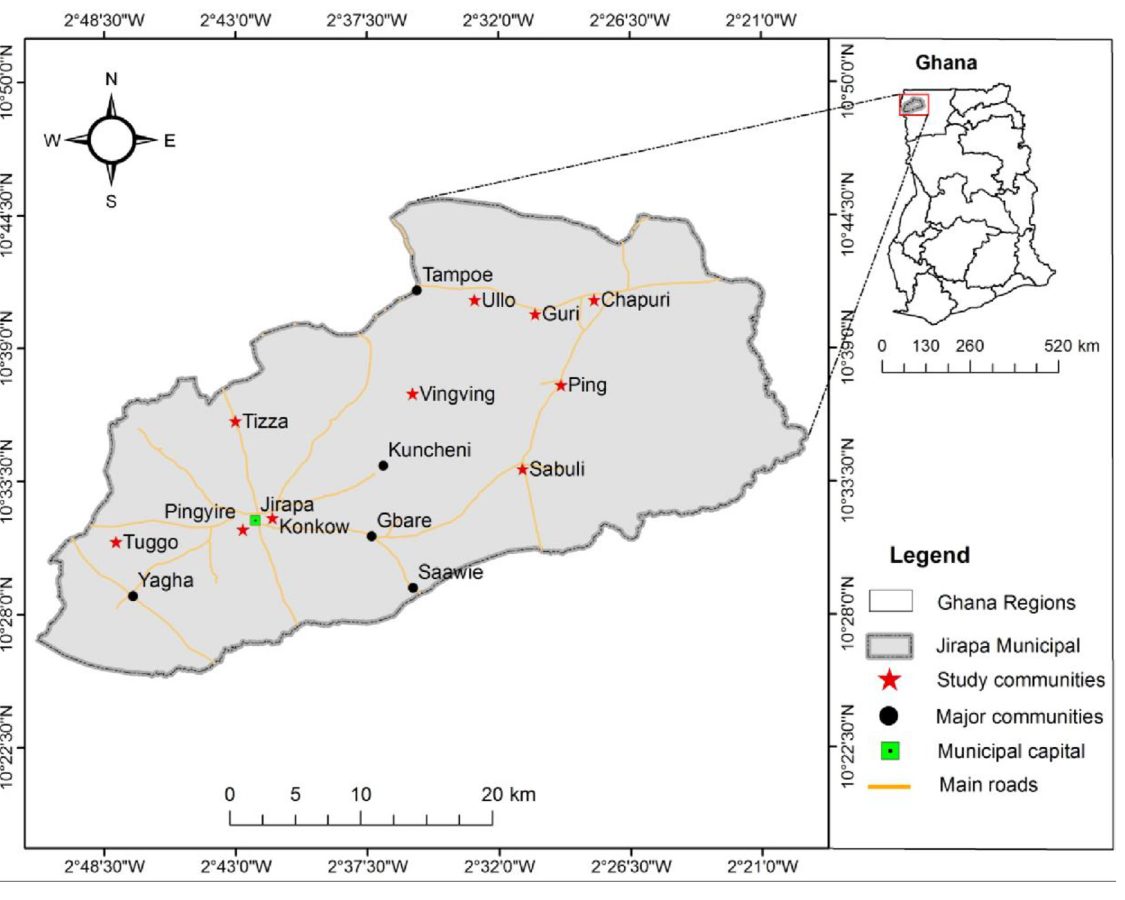
Fig 1. Map of the study